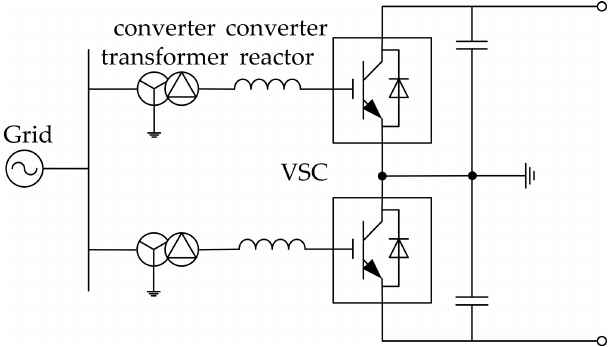
Figure 2. Structure of the bipolar voltage source converter station.